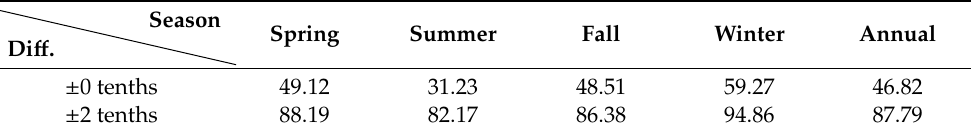
Table 3. Agreement frequency (%) according to the seasonal and annual cloud cover di ff erence (Di ff .) between ACOS and DROM in